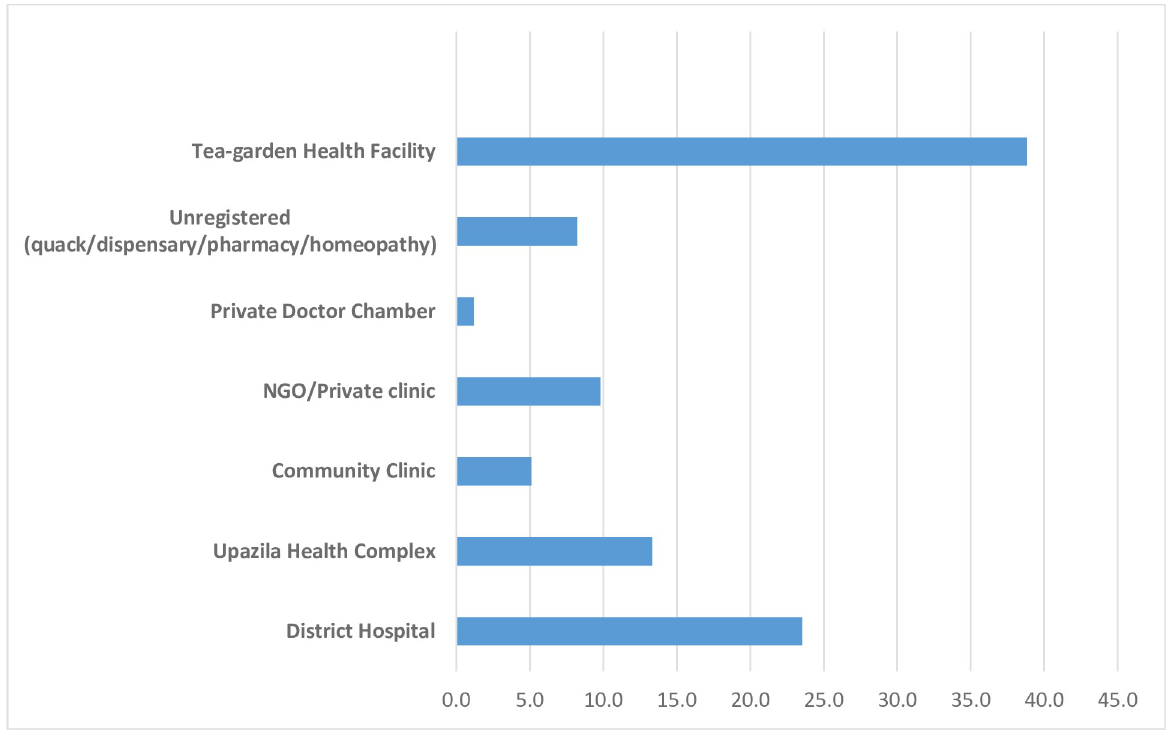
Fig 5. Facilities from where indigenous older adults received treatment.